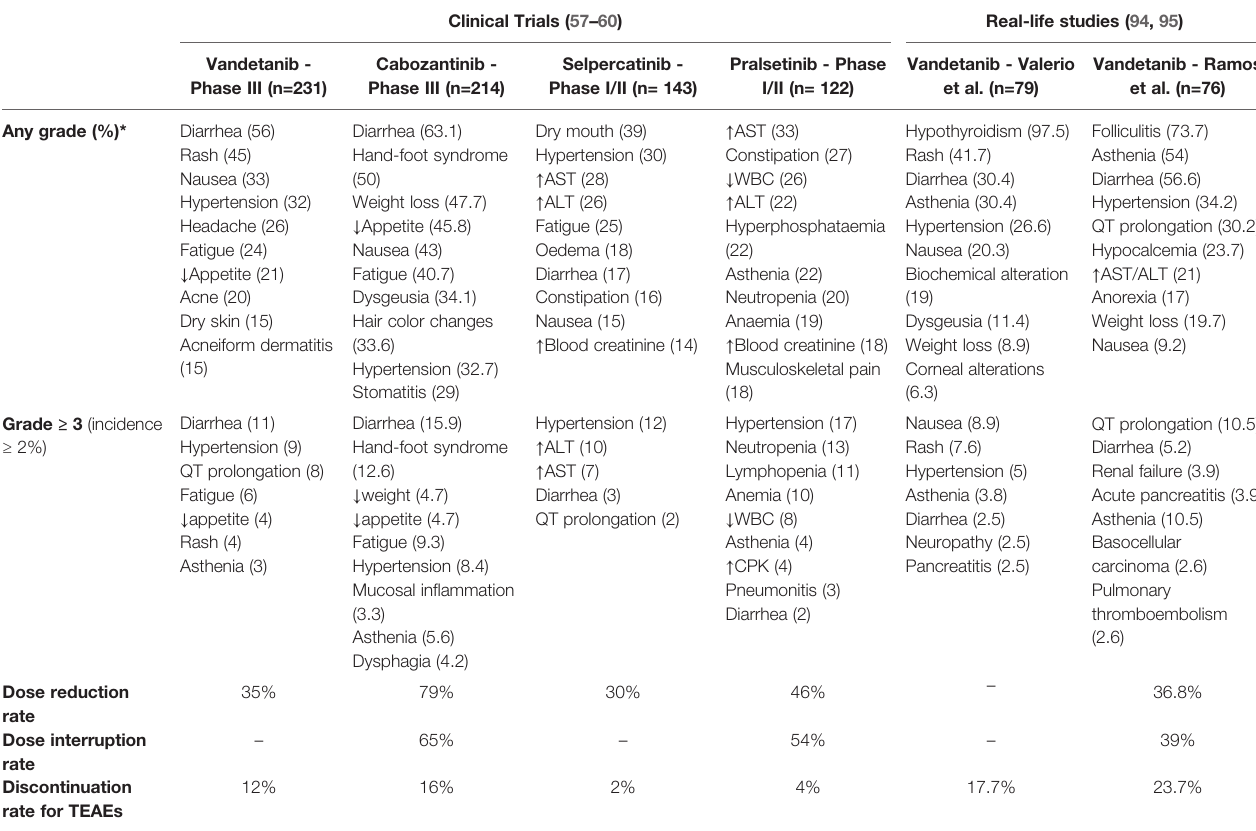
TABLE 2 | Most frequent treatment emergent adverse events (TEAEs) reported in the clinical trials and in the real-life